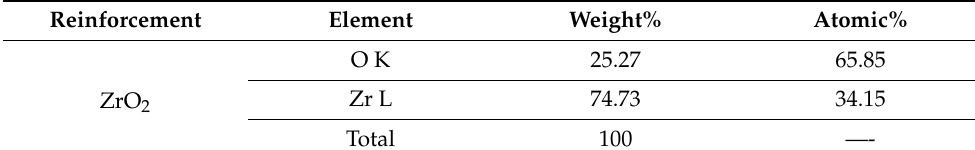
Table 3. The EDX analysis of the ZrO 2 nano powder.